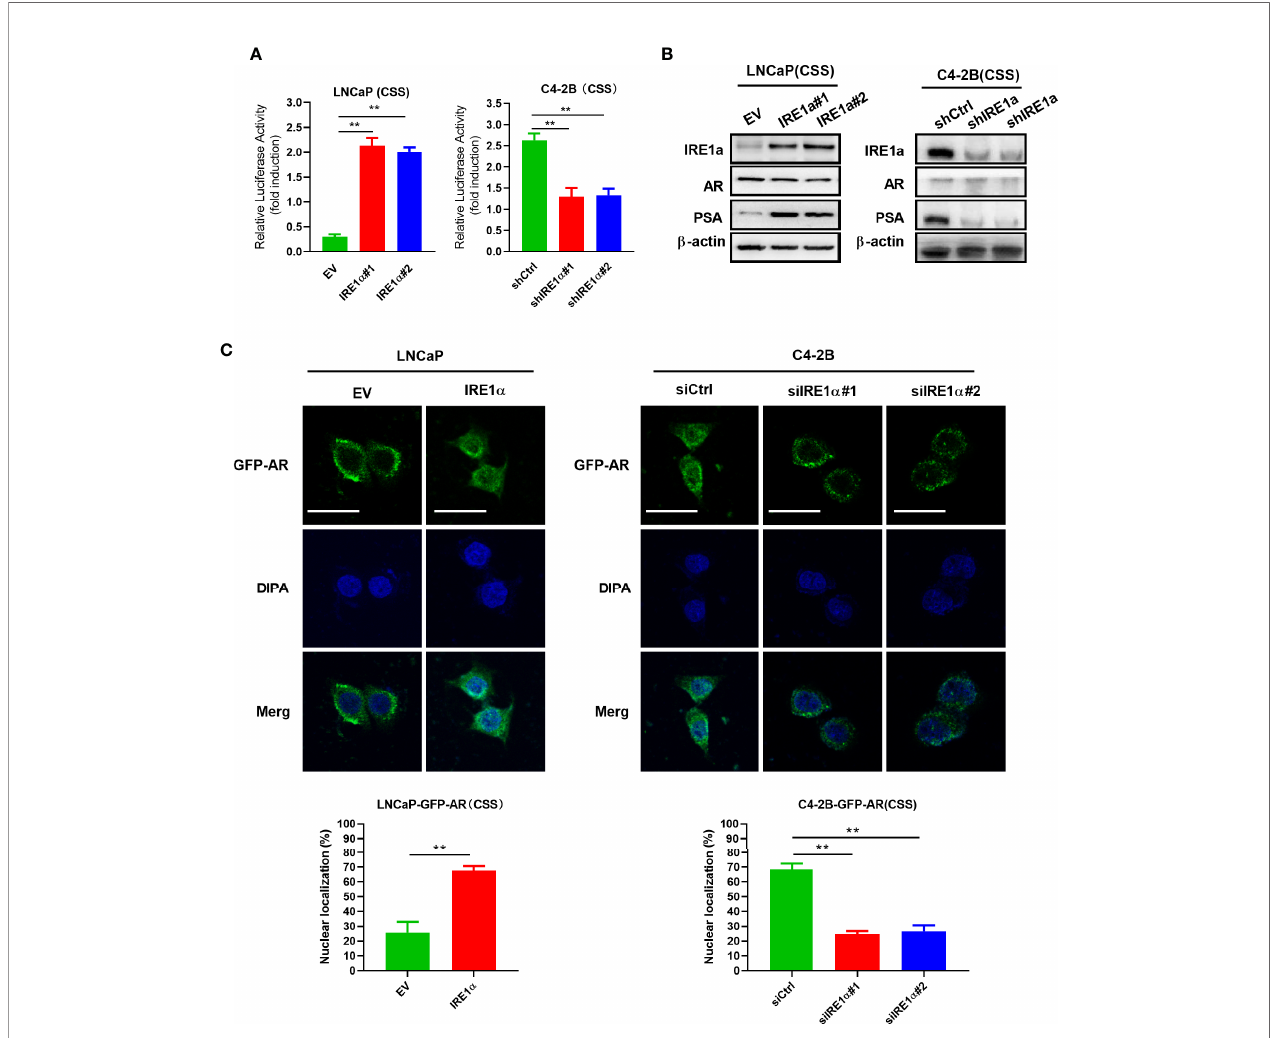
FIGURE 3 | Overexpression of IRE1 a induces androgen receptor activation. (A) IRE1 a expression affects AR transcriptional activity. LNCaP cells with IRE1 a overexpression or C4-2B cells with IRE1 a knockdown were transiently transfected with PSA-Luc and then cultured in CSS medium. Luciferase activity was assayed 48 h after transfection. (B) IRE1 a expression affects AR activation without affecting the AR level. Representative western blot analyses of the expression of IRE1 a , AR, and the AR target gene PSA in LNCaP cells with IRE1 a overexpression or C4-2B cells with IRE1 a knockdown. (C) IRE1 a expression affects the subcellular localization of GFP-AR. LNCaP cells and C4-2B cells stably expressing GFP-AR were transiently transfected with empty vector (EV) or IRE1 a expression vector (IRE1 a ), control siRNA (siCtrl) or IRE1 a siRNA, and then cultured in the medium with of CSS for 48h, confocal microscopy was used to visualize the subcellular localization of GFP-AR. Data shown are the mean ± SD from three independent experiments, **P <